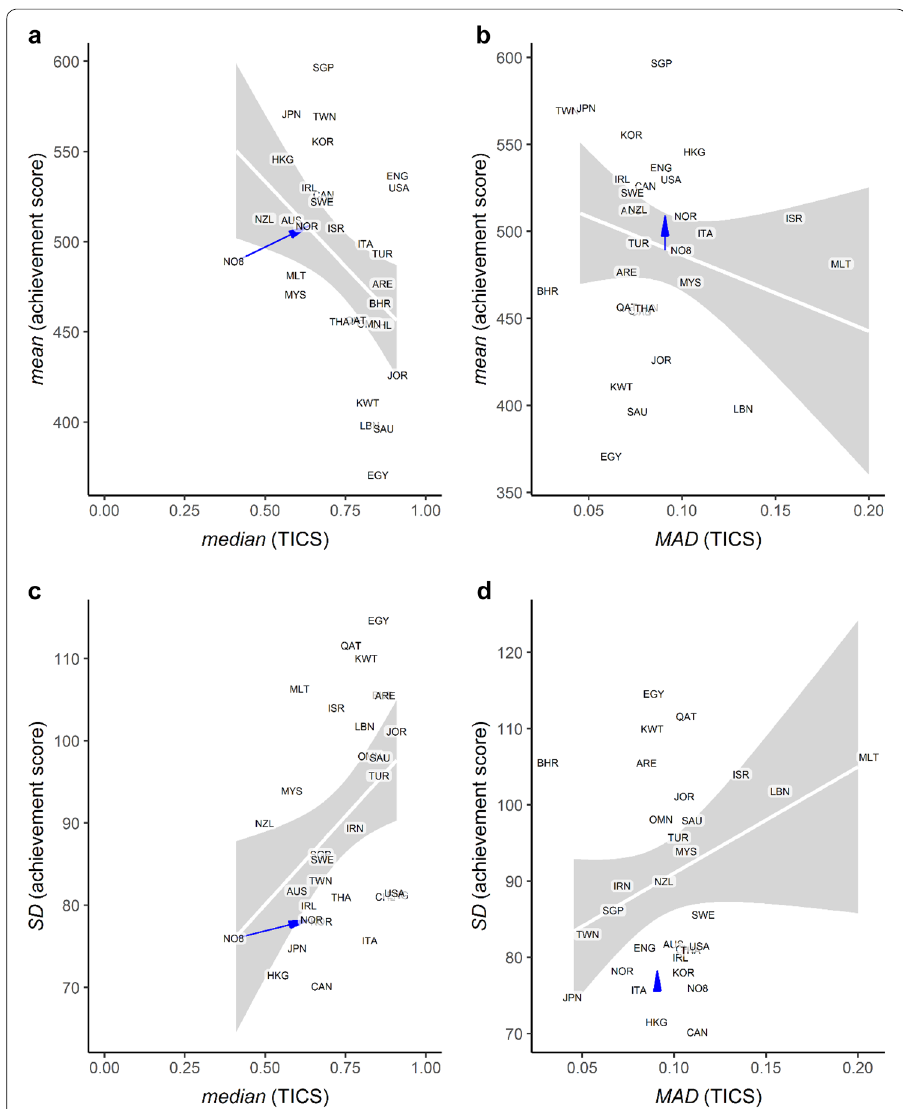
Fig. 3 a – d Scatterplots of between-country relationships between central tendency (mean achievement and median TICS) and spread (standard deviation of achievement and median absolute deviation of TICS). The white line is the best simple linear fit line, and the gray band is its 95% confidence interval (bootstrapped from 10,000 draws). As there was little between-country variation in median absolute deviation (MAD) of TICS, the x -axis values in b and d were slightly jittered to increase visibility of points. The blue arrow indicates the shift from Norway grade 8 to grade